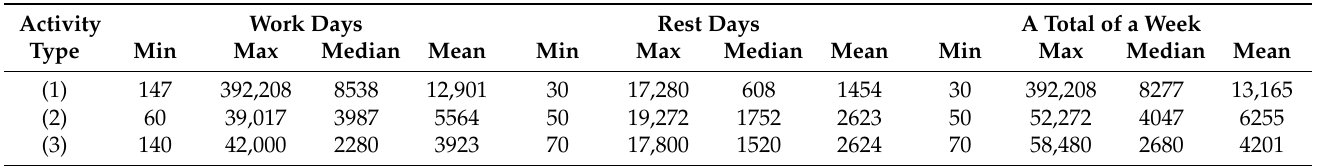
Table 4. Exposure level of three kinds of activities.